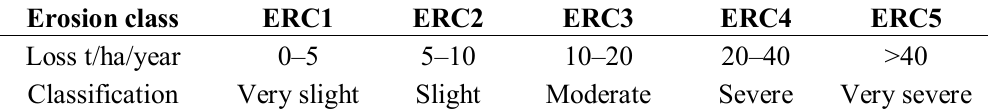
Table 2. Erosion risk classes (ERC) proposed by Wischmeier and Smith (1978).